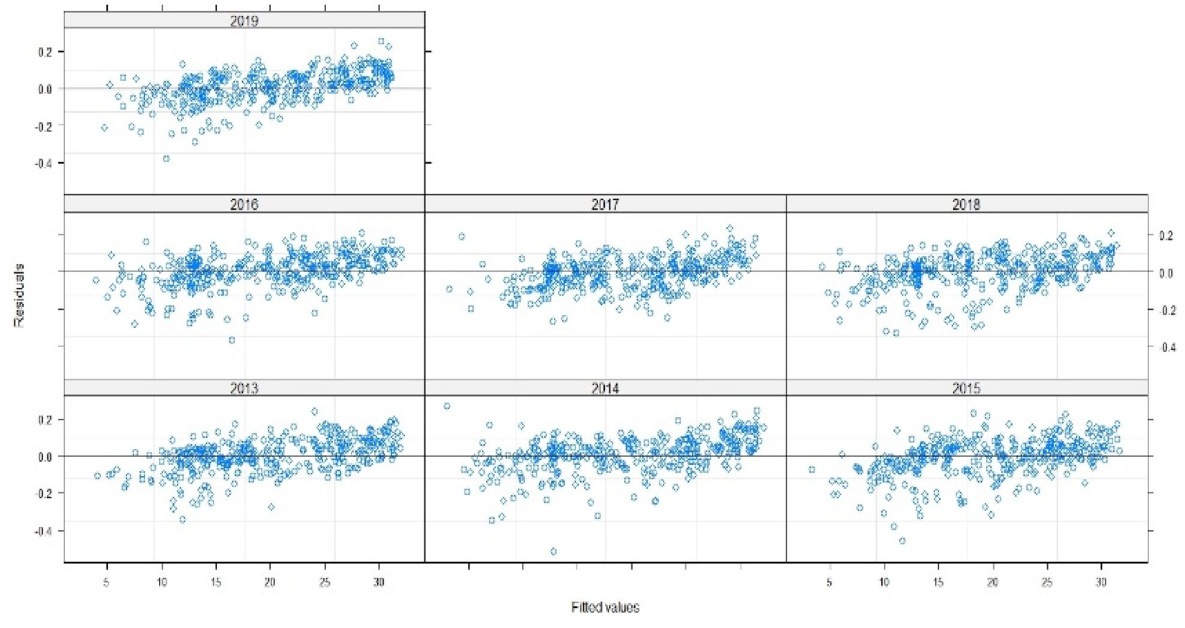
Figure 8. Errors in terms of the adjusted values.